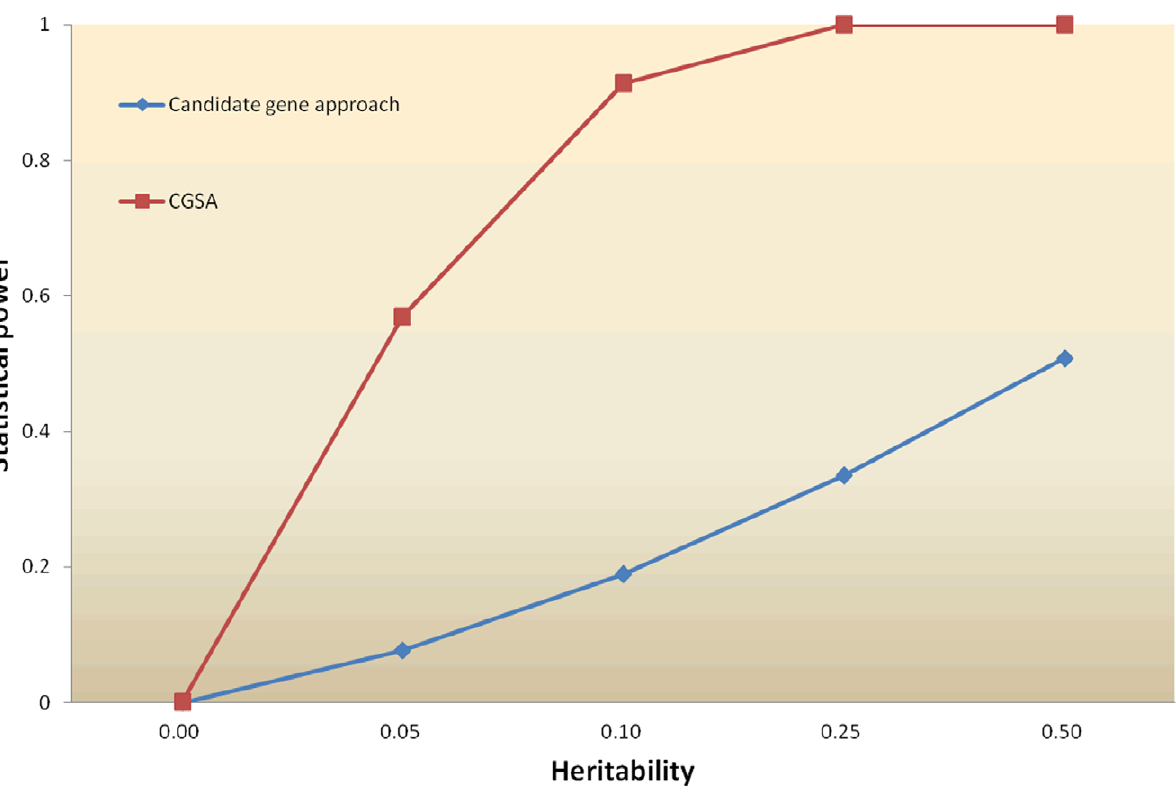
Figure 1. Statistical powers between CGSA and candidate gene approach under different heritability levels. The power was examined on a trait simulated from 15 causative mutations (QTNs). A total of 1000 replications were conducted for each method. The heritability of the trait varied from 0 to 0.5. The differences between our CGSA and candidate gene set approach with mid-level and low-level of heritability were greater than the one with high heritability.